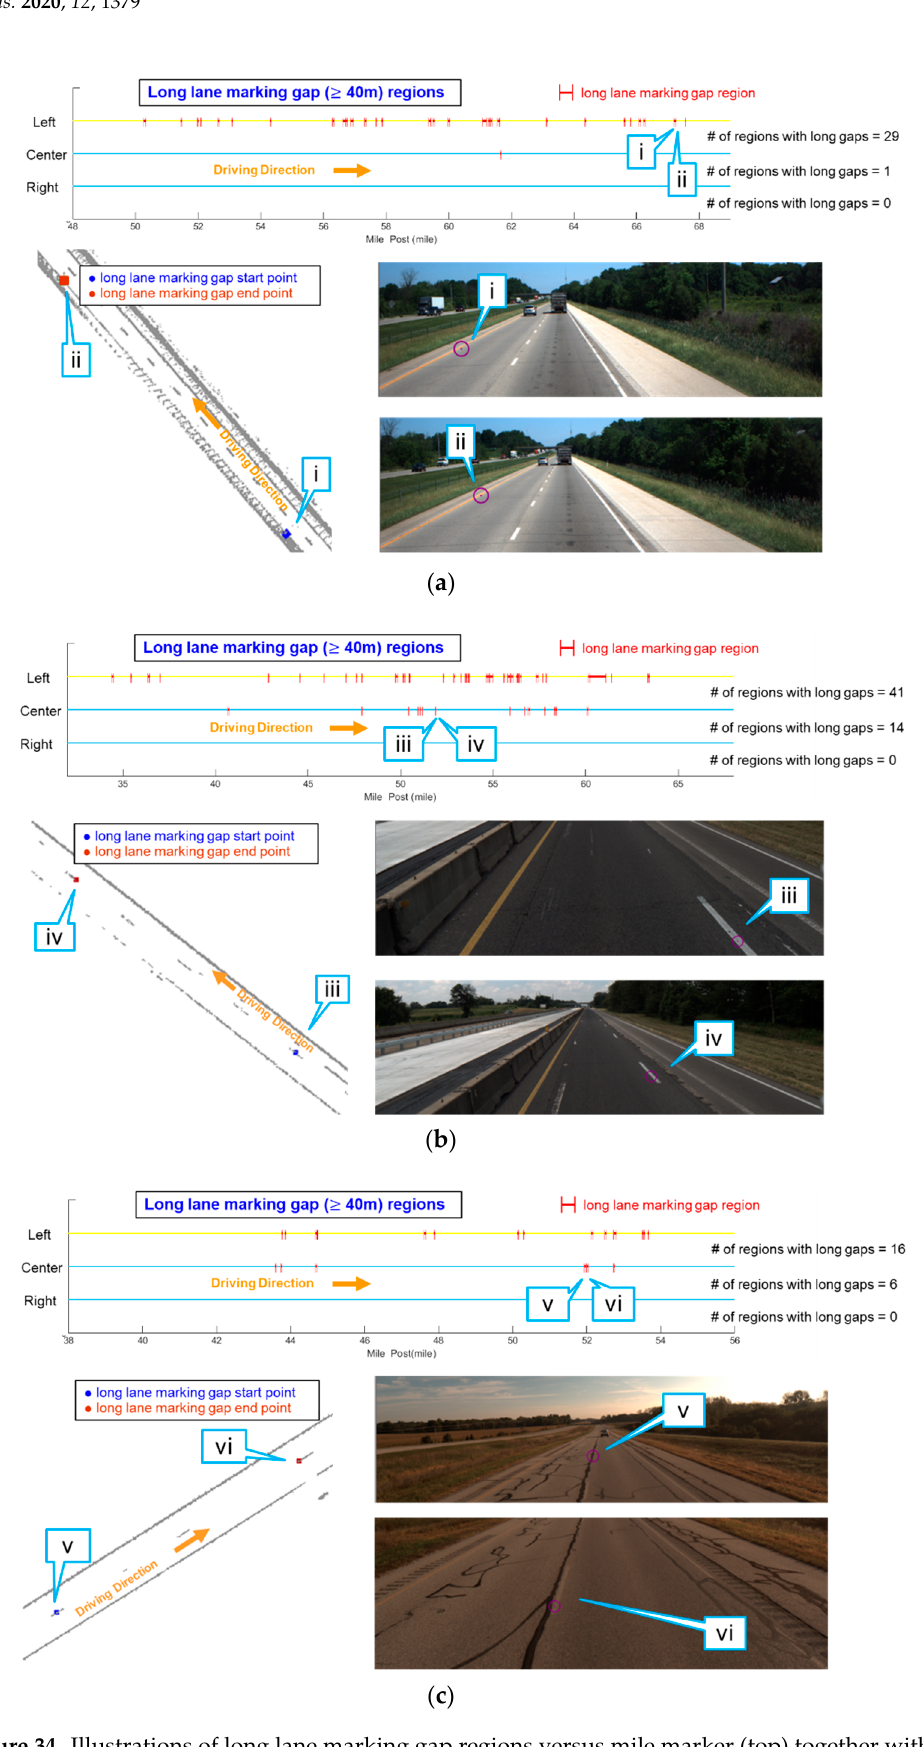
Figure 34. Illustrations of long lane marking gap regions versus mile marker (top) together with an example location defined by start and end points overlaid on hypothesized lane markings (bottom-left) and corresponding RGB imagery (bottom-right) for ( a ) dataset 1, ( b ) dataset 2, and ( c ) dataset 3.